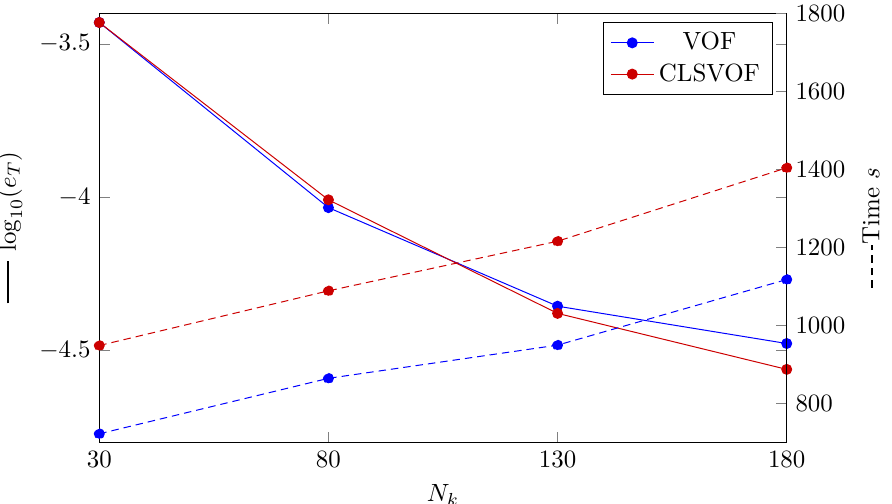
Figure 4. (Solid lines) The error’s logarithmic representation where e T is the L2 norm error computed by Equation (22). (Dashed lines) VOF and CLSVOF computation times for the Stefan problem at various grid